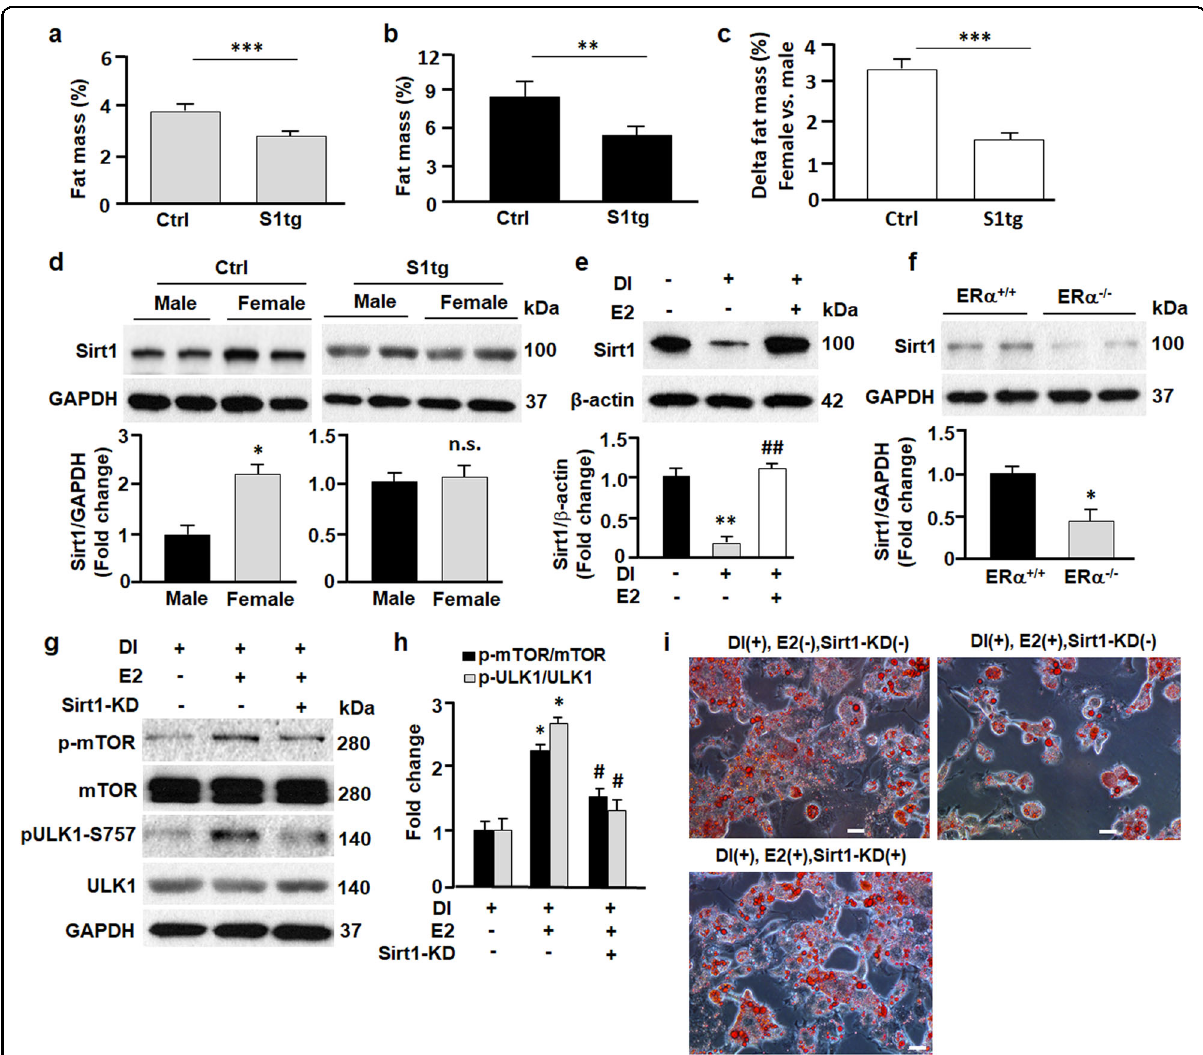
Fig. 5 Sirt1 regulated sex difference in adiposity. a , b Fat mass in male ( a ) and female ( b ) mice. ** p < 0.01; *** p < 0.001; n = 6 – 10. c Sex difference (females vs males) in adiposity was greater in Ctrl mice compared to S1tg mice. *** p < 0.001; n = 6 – 10. d Sirt1 expression in inguinal adipose tissues was analyzed by Western blotting and densitometric analyses. * p < 0.05; n.s., not signi fi cant; n = 6. e The effects of estradiol (E2, 0.1 μ M) on Sirt1 in 3T3L1 cells were analyzed by Western blotting and densitometric analyses. β -actin was probed as a loading control. ** p < 0.01 by comparing DI( − )E2 ( − ) with DI( + )E2( − ). ## p < 0.01 by comparing DI( + )E2( − ) with DI( + )E2( + ). n = 8. f The effects of estrogen receptor α knockout (ER α − / − ) on Sirt1 in inguinal adipose tissues were analyzed by Western blotting and densitometric analyses. GAPDH was probed as a loading control. * p < 0.05 by comparing estrogen receptor α knockout (ER α − / − ) mice with wild type (ER α + / + ) mice. n = 8. g The effects of E2 (0.1 μ M) and Sirt1 knockdown (Sirt1- KD), alone or combined, on mTOR-ULK1 cascade (day 9). Western blotting ( g ) and densitometric analyses ( h ) were employed to determine the effects. * p < 0.05 by comparing DI( + )E2( − )Sirt1-KD( − ) with DI( + )E2( + )Sirt1-KD( − ). # p < 0.05 by comparing DI( + )E2( + )Sirt1-KD( − ) with DI( + )E2( +